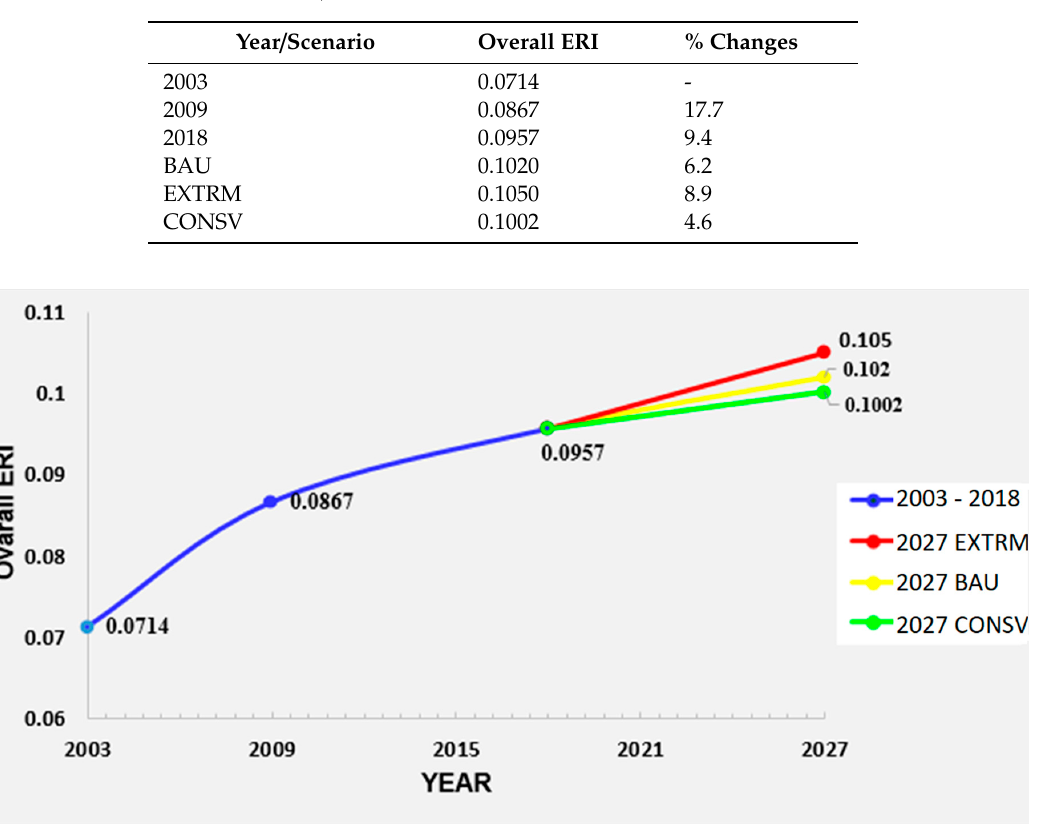
Figure 10. Trends of overall ERI from 2003–2027 (EXTRM: Extreme; BAU: Business as usual; CONSV: Conservation).